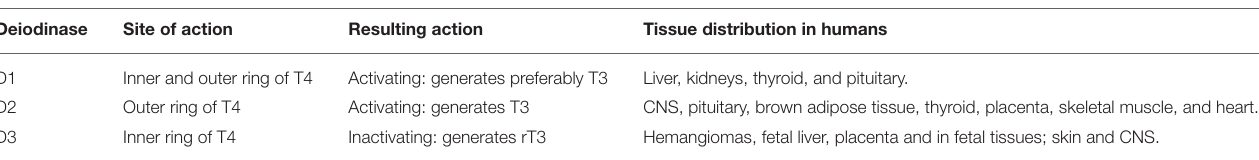
TABLE 1 | Tissue distribution of